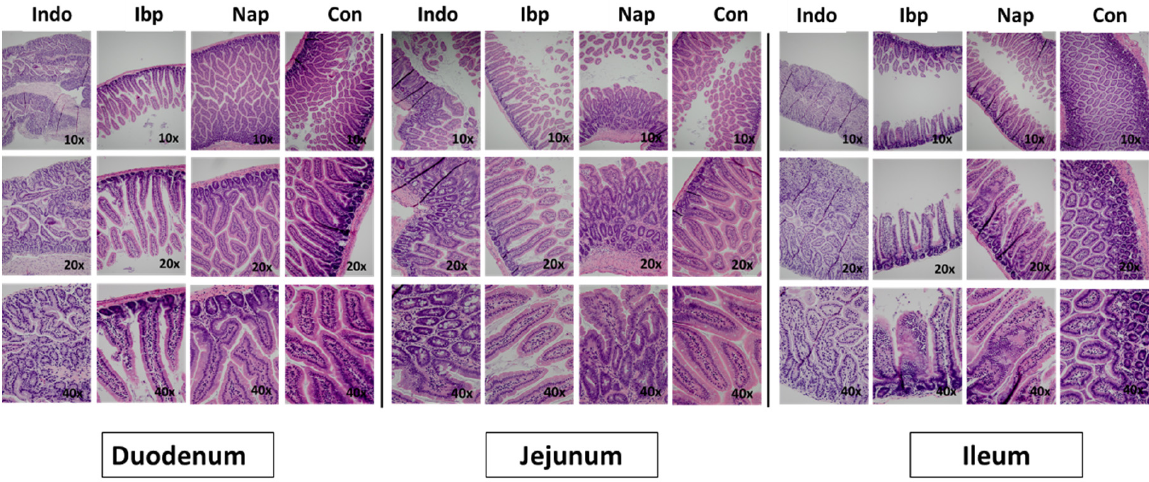
Figure 1. Histological effect of variable NSAIDs on multiple sections of the small intestine. Hema- toxylin and Eosin (H&E) staining of duodenum, jejunum and ileum (at variable magnifications 10×, 20×, and 40×) in C57 Blc/6J male mice treated with indomethacin (Indo), ibuprofen (Ibp), naproxen (Nap), or PBS (Con) for 6 weeks. n = 5–6.